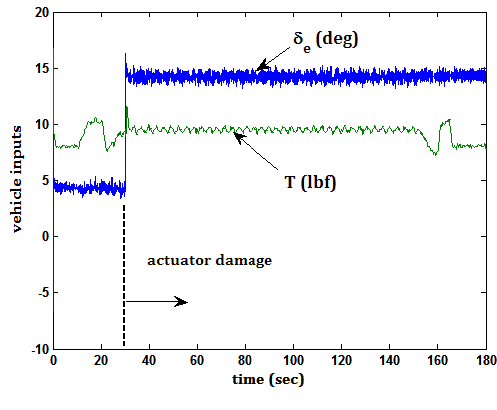
Figure 18. Elevator and thrust inputs for Task